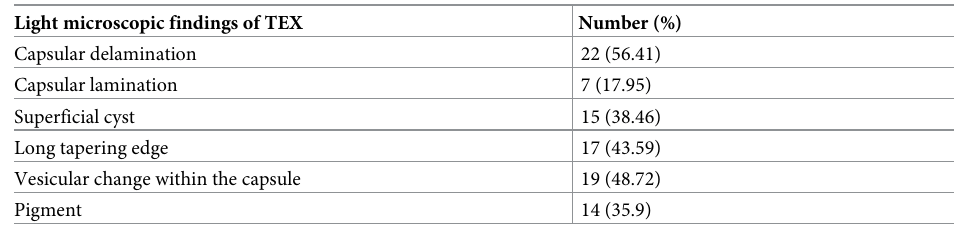
Table 2. Light microscopic findings in true exfoliation syndrome group.